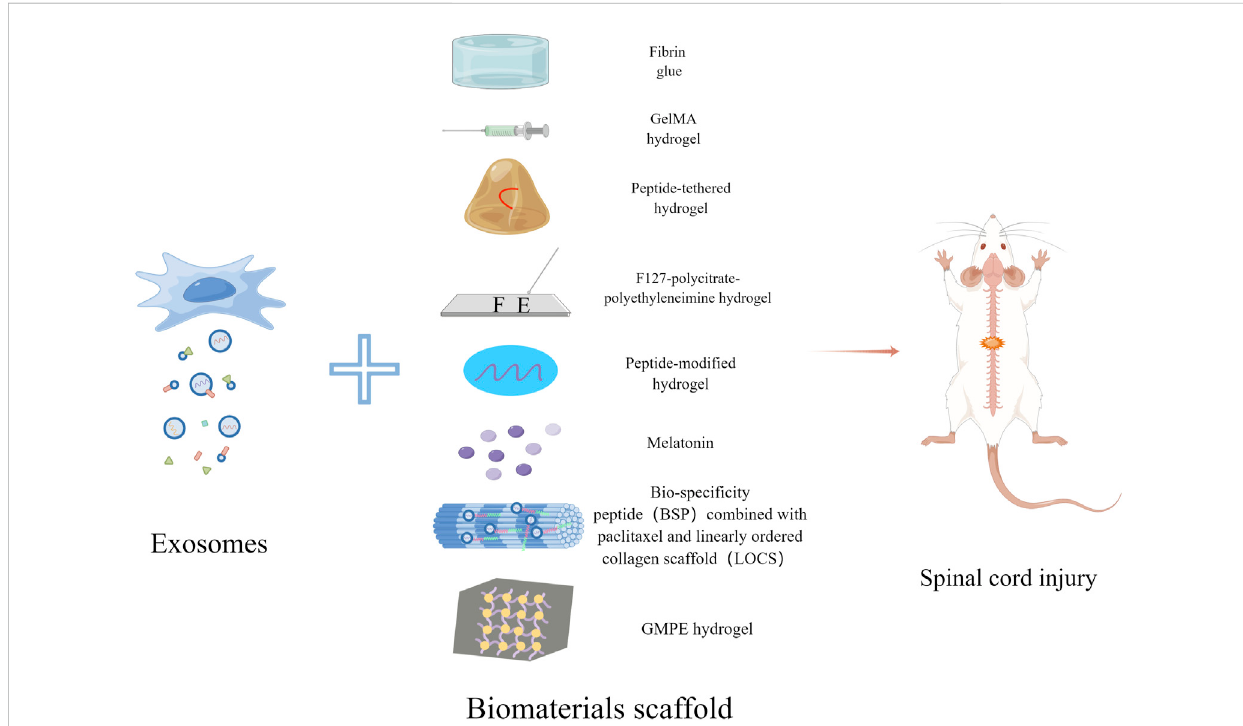
FIGURE 1 Schematic diagram of exosomes combined with biomaterials for the treatment of SCI. Exosomes derived from stem cells can be combined with Fibrin glue, GelMA hydrogel, Peptide-tethered hydrogel, F127-polycitrate-polyethyleneimine hydrogel, Peptide-modi fi ed hydrogel, Melatonin, LOCS- BSP and GMPE hydrogel respectively to treat spinal cord